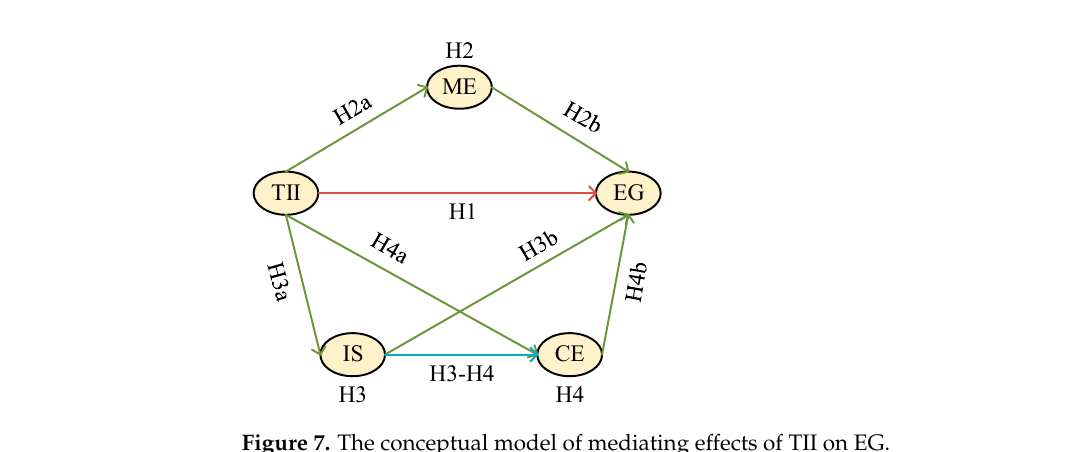
Figure 7. The conceptual model of mediating effects of TII on EG.